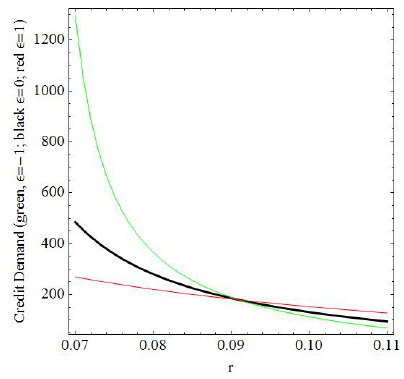
Figure 13: Credit demand for different ε (black → ε = 0 , red → ε > 0 , green → ε < 0